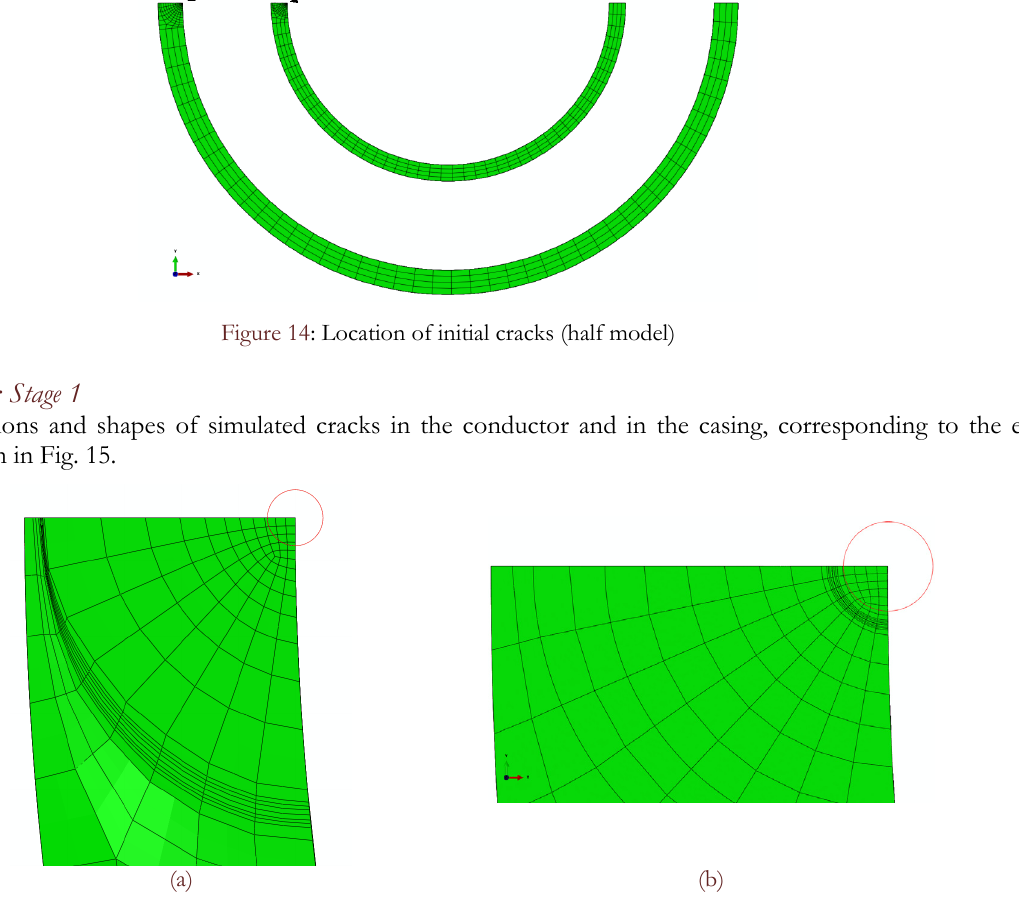
Figure 15: Simulated final crack shape at the end of Stage 1 analysis: (a) conductor; (b) casing. The circle show the initial crack configuration.